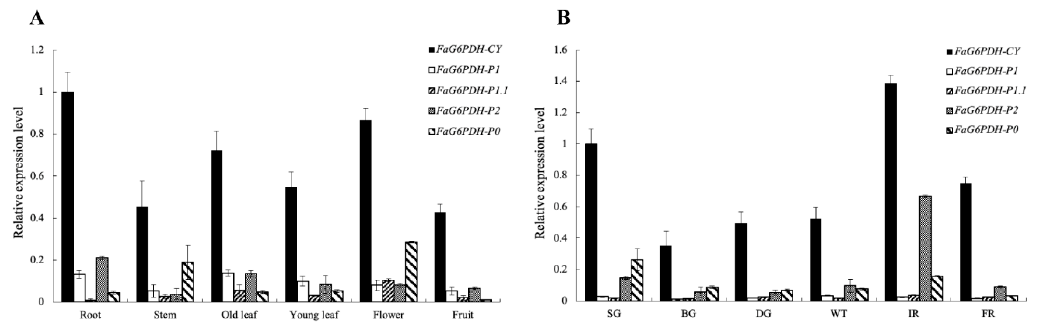
Figure 2. Expression profile of FaG6PDHs in different tissues and during the fruit development. ( A ) qRT-PCR analysis of FaG6PDHs in different tissues. ( B ) qRT-PCR analysis of FaG6PDHs during different fruit developmental stages. SG, small green; BG, big green; DG, de-green; WT, white; IR, initial red; FR, full red.